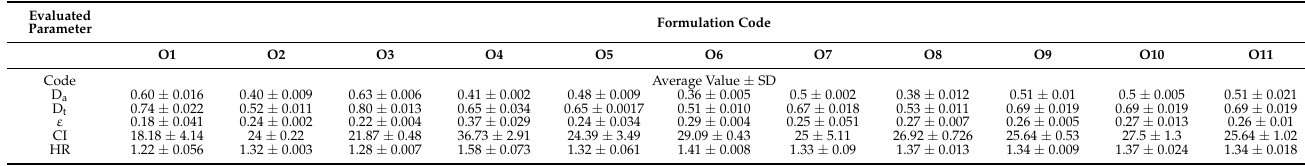
Table 4. The powder evaluation for O1–O11 CBD